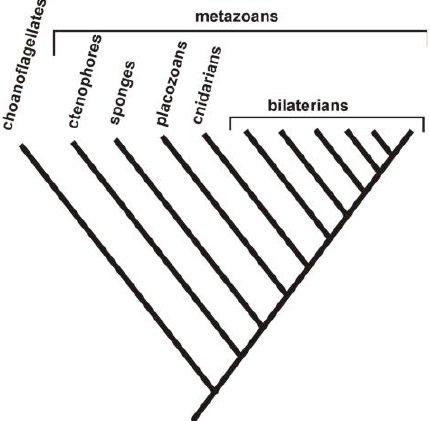
Figure 4. The use of ubiquinone and rhodoquinone in electron transport. ( a ) As part of the reductive branch of malate dismutation under anaerobic conditions, NADH is oxidized to NAD + by complex